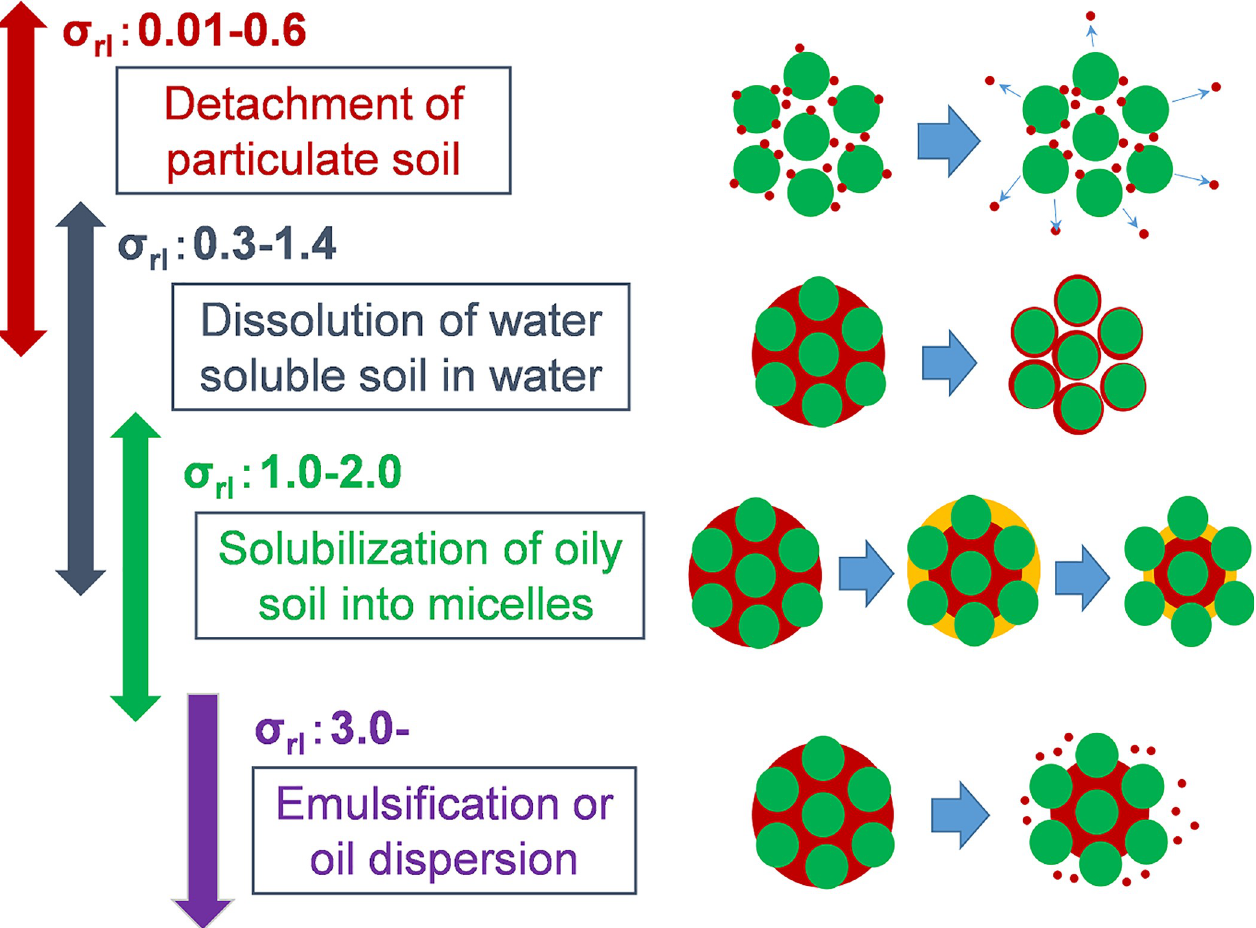
Fig 3. Relationship between the soil removal mechanism and values of σ